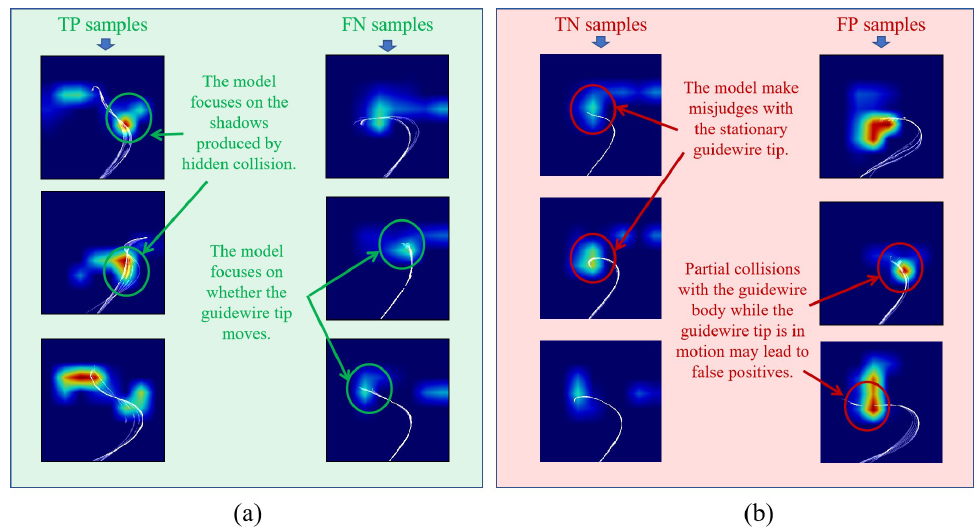
Figure 7. Class activation maps. We visualize the features of the last layer of GCCM-net and superimpose them on the original image (3D images are also superimposed). The red color in the figure represents the area where the weight is activated, and the blue color represents the area that is not activated. Where ( a ) represents correctly identified TP and FN samples, and ( b ) represents incorrectly identified TN and FP